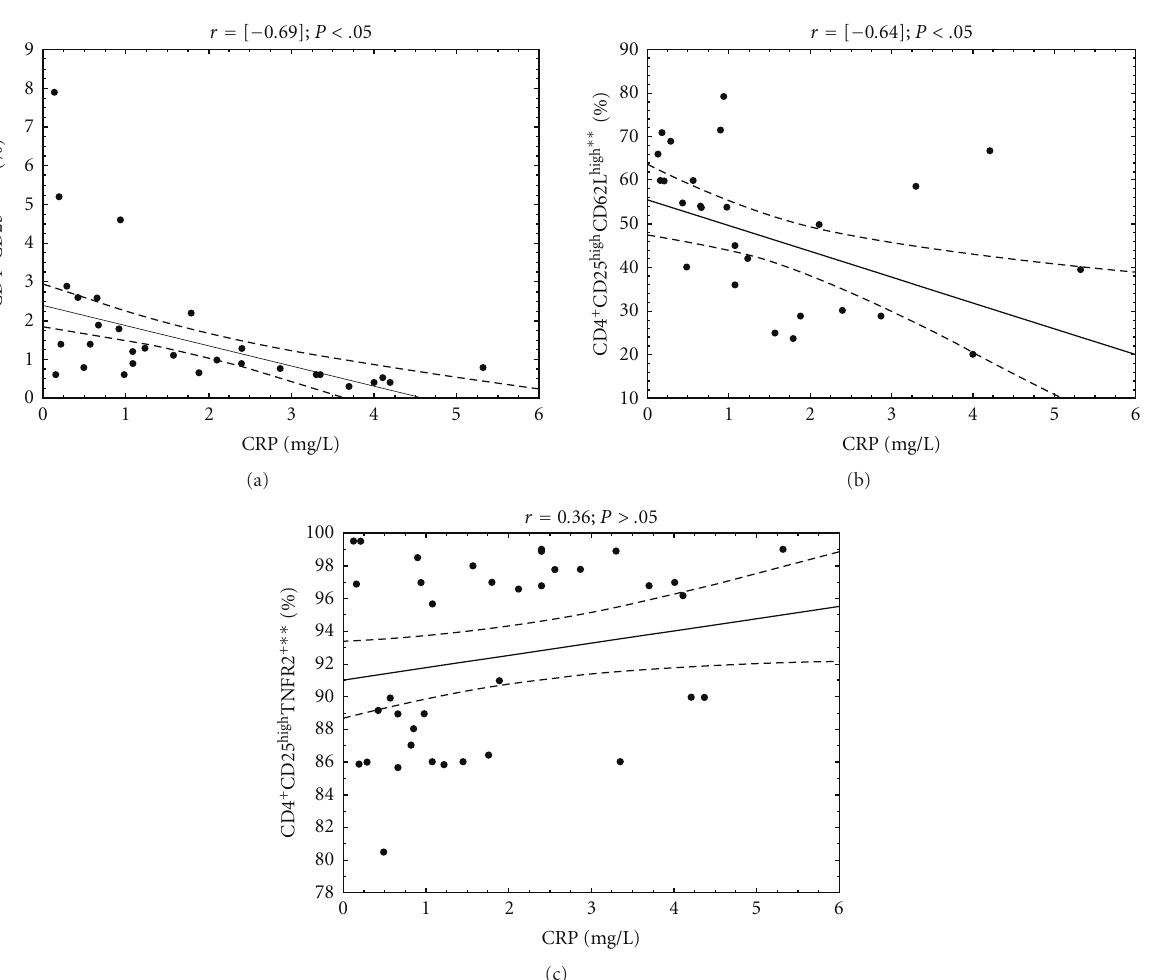
Figure 4: Relationship between CD4 + CD25 high regulatory T cells, their subpopulations frequencies, and CRP level in analyzed DM1 subjects. The level of C-reactive protein was measured in the blood of DM1 children and correlated with the percentage of peripheral blood regulatory T-cell subpopulations. The Spearman test was used to calculate the strength of correlation. (a) The correlation between CD4 + CD25 high frequency and CRP level in DM1 subjects ( r = [ − 0 . 69]); (b) the correlation between CD4 + CD25 high CD62L high frequency and CRP level in DM1 subjects ( r = [ − 0 . 64]); (c) the correlation between CD4 + CD25 high TNFR2 + frequency and CRP level in DM1 subjects ( r = 0 . 36). ∗ The percentage of cells among peripheral blood lymphocytes, ∗∗ the percentage of cells among CD4 + CD25 high